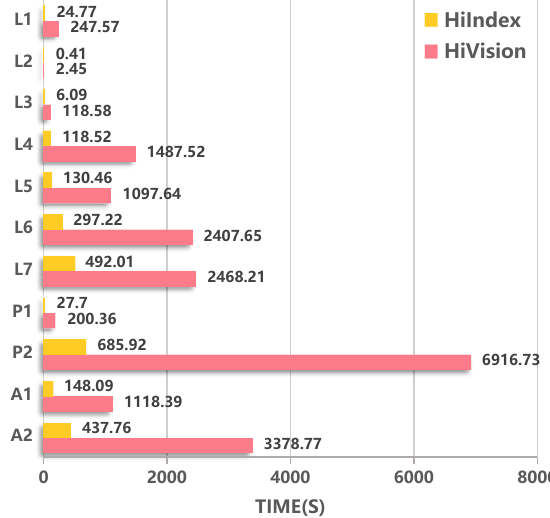
Figure 7. Index build time of different datasets. Figure 8 compares the occupation of the output index of the two methods in disk storage. From the experimental results, the index occupation of HiIndex is much smaller than that of HiVision. For the billion-scale datasets L 7 , P 2 , and A 2 , the index size is only 2.72% (=4.09 GB ÷ 150.61 GB), 1.77% (=4.33 GB ÷ 244.28 GB), and 1.55% (=3.06 GB ÷ 197.98 GB) of HiVision respectively. The reason is that TQTG only needs to store TQ-tree node information, thus saving a lot of storage space.